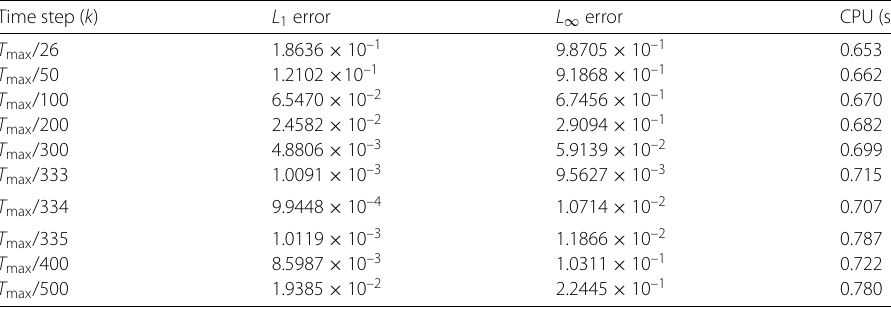
Table 8 L 1 and L ∞ errors and CPU time at some different values of time-step size k for Problem 1 at time 2.5 × 10 –3 with spatial mesh size h = 0.01, (cid:5) = 0.01 using NSFD- (cid:5) scheme, T max = 2.5 × 10 –3